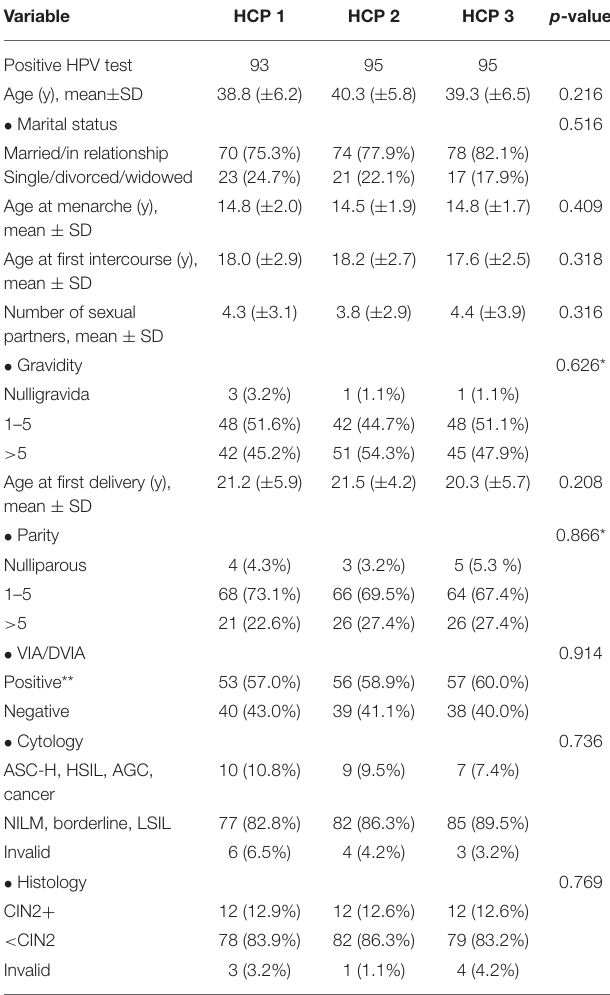
TABLE 2 | Sociodemographic characteristics of HPV-positive participants seen by